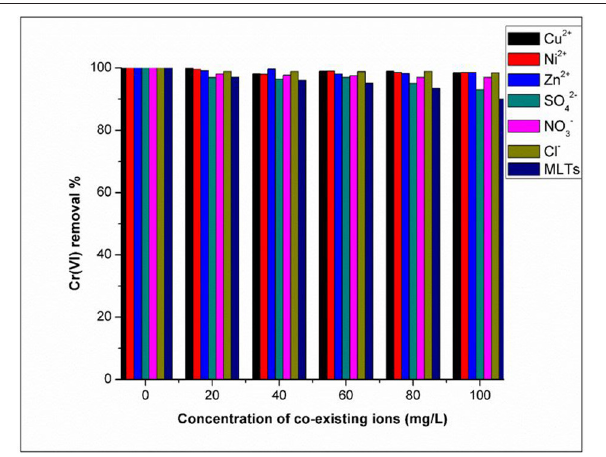
FIGURE 10 | Cr(VI) removal in the presence of co-existing